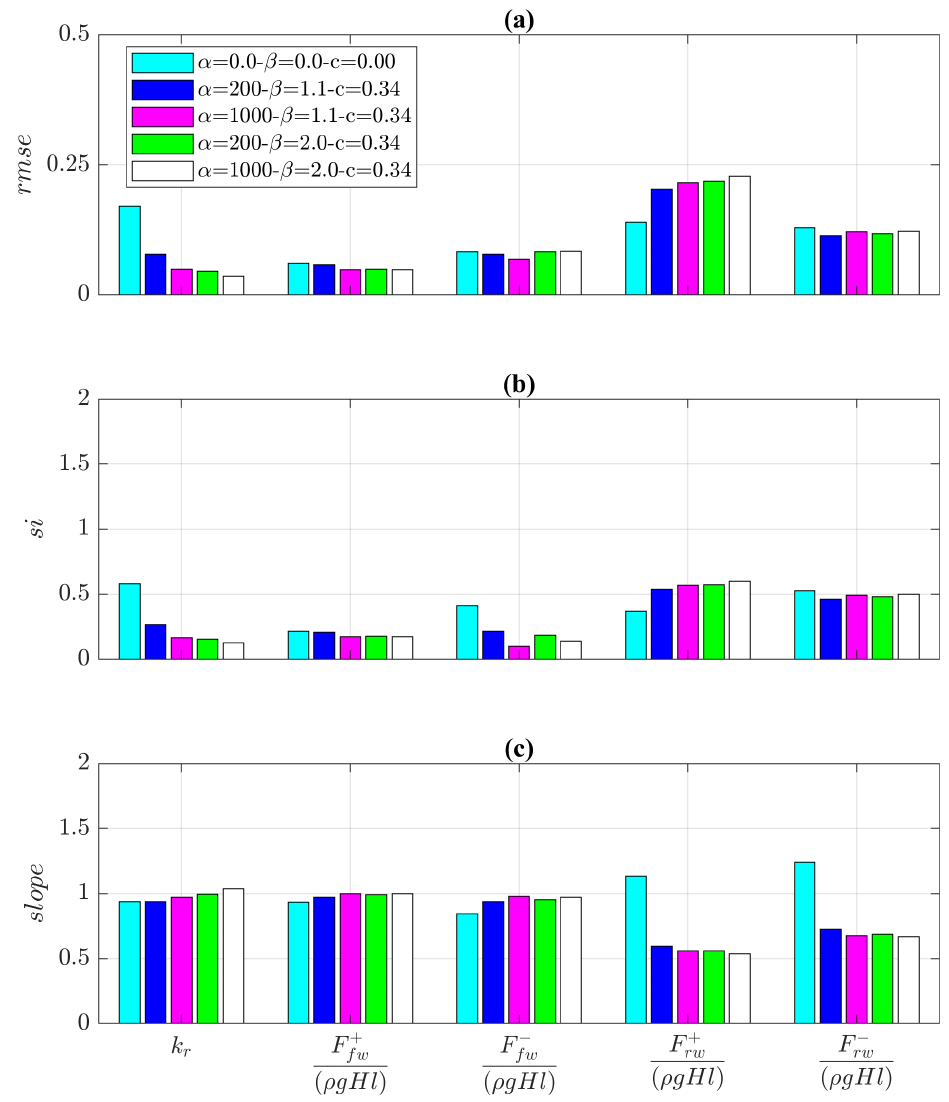
Figure 13. Performance of the configurations tested expressed through rmse ( a ), si ( b ) and slope ( c